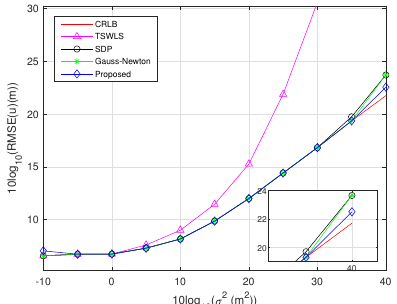
Figure 5. RMSE comparison for estimating target position at σ 2 s = 1 m 2